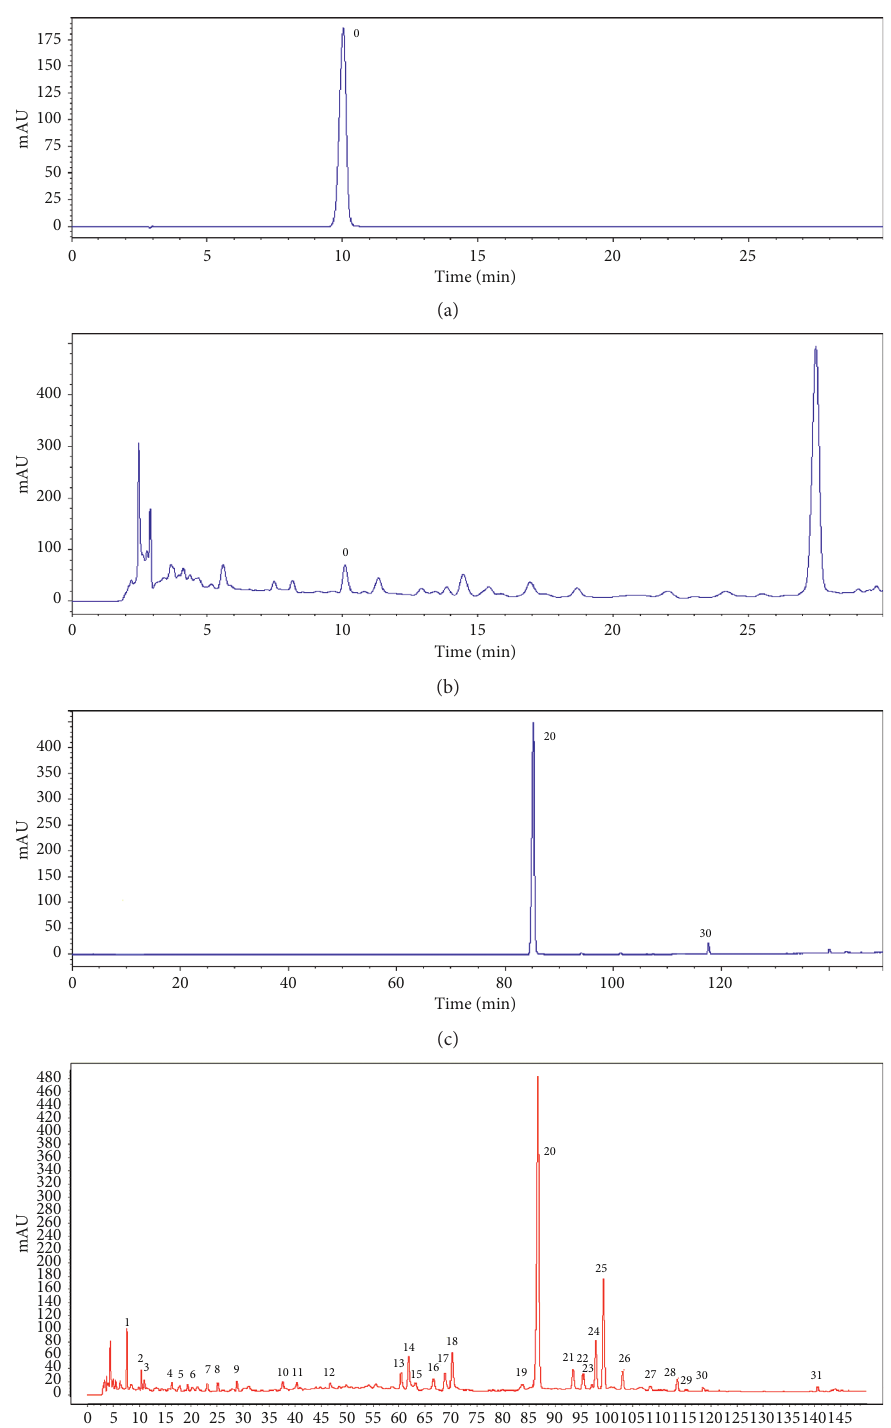
Figure 2: HPLC-UV (PDA) chromatograms obtained from the standard of forsythoside A (a), the sample solution (b), a mixture of two standards (c), and HPLC fingerprint of Zhideke granules